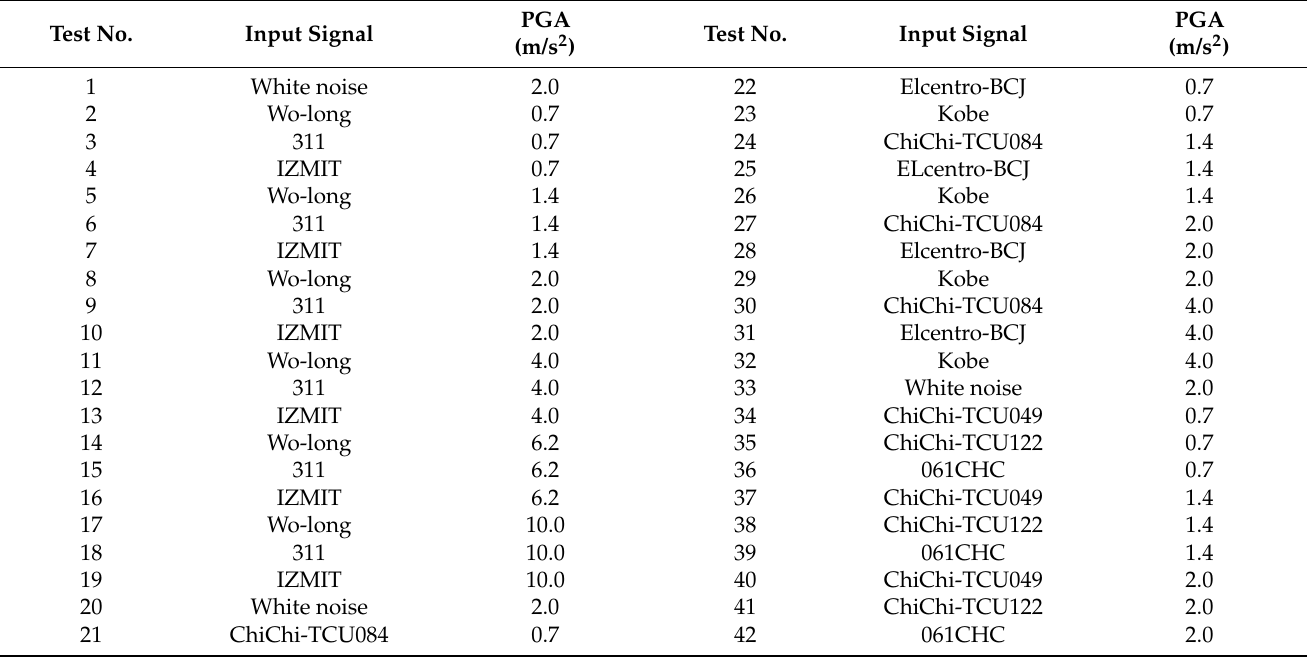
Figure 18. ( a ) Frequency spectrums of input accelerations with ( a ) and response spectrums with ( b ); Response spectrums of input velocities with ( c ) and input displacements with ( d ). Table 4. Test program of the pendulum